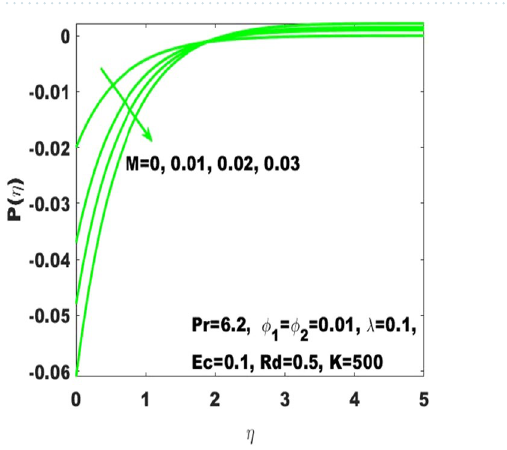
Figure 15. P ( η ) for the diverse values of K.